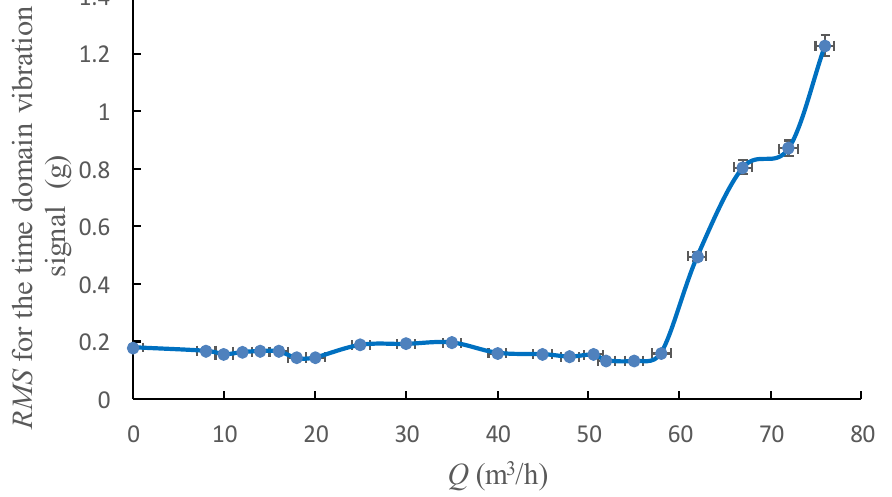
Figure 9. Root mean square ( RMS) for the time domain vibration signal under different flowrates.